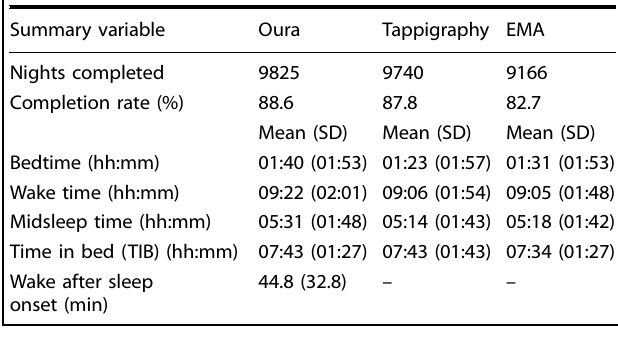
Table 1. Sleep estimates obtained from each modality.